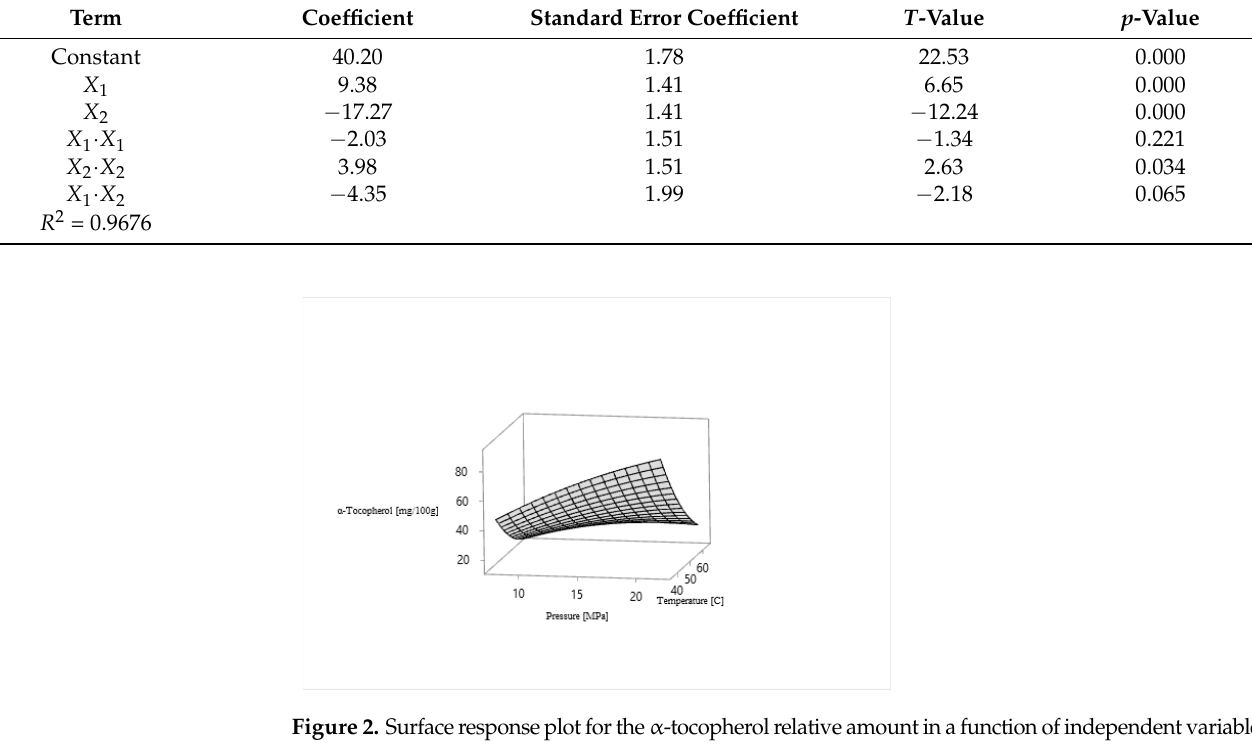
Table 4. The response surface regression coefficients of the polynomial function for the α -tocopherol relative amount of T. distichum needle leaves (mg α -tocopherol equivalents per 100 g of plant material).